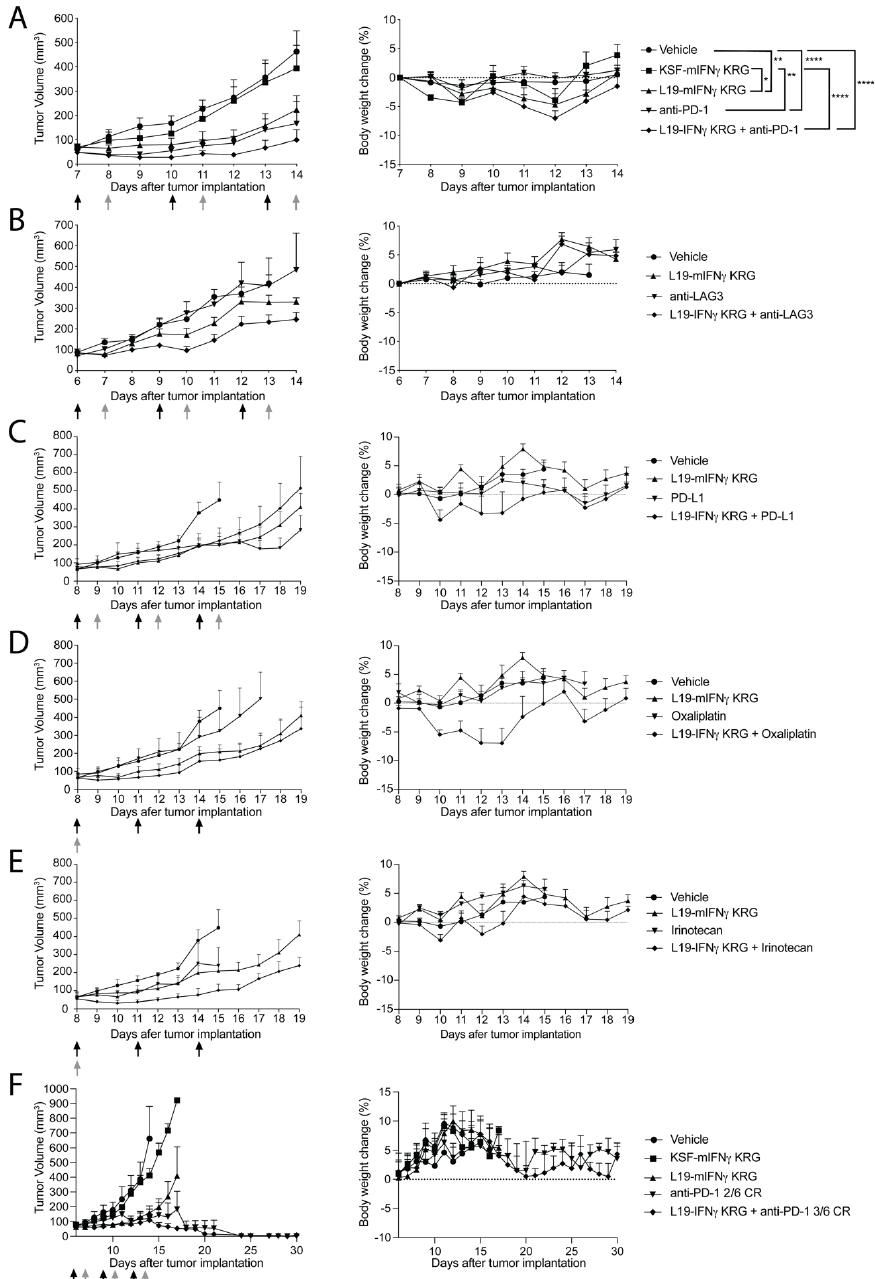
Figure 5. Therapeutic performance of L19-mIFN γ KRG. ( A ) CT26 tumor bearing mice received either Ringerfundin, KSF-mIFN γ KRG 20 µ g, L19-mIFN γ KRG 20 µ g, anti-PD-1 200 µ g (black arrows) three times every 72 h or L19-mIFN γ KRG 20 µ g in combination with anti-PD-1 200 µ g (grey arrows; n = 5 mice per group). ( B ) CT26 tumor bearing mice received either Ringerfundin, anti-LAG-3 200 µ g, L19-mIFN γ KRG 20 µ g, (black arrows) three times every 72 h alone or in combination with anti- LAG-3 200 µ g (grey arrows; n = 3 mice per group). Third Therapy in CT26 tumor bearing mice treated with either Ringerfundin, L19-mIFN γ KRG 20 µ g, anti-PD-L1 200 µ g ( C ), oxaliplatin 2.5 µ g/g ( D ) or irinotecan (9 µ g/g) ( E ) or the combination administered three times. (n = 3–4 mice per group) Irinotecan alone or in combination received one single i.p. injection (grey arrow). ( F ) Therapy study in BALB/c mice bearing WEHI-164 lesions. The same dose and schedule treatment of ( A ) was used. Data represent mean tumor volume and body weight change % ( ± SEM). CR = Complete Response. (*: p < 0.05, **: p < 0.01, ****: p <